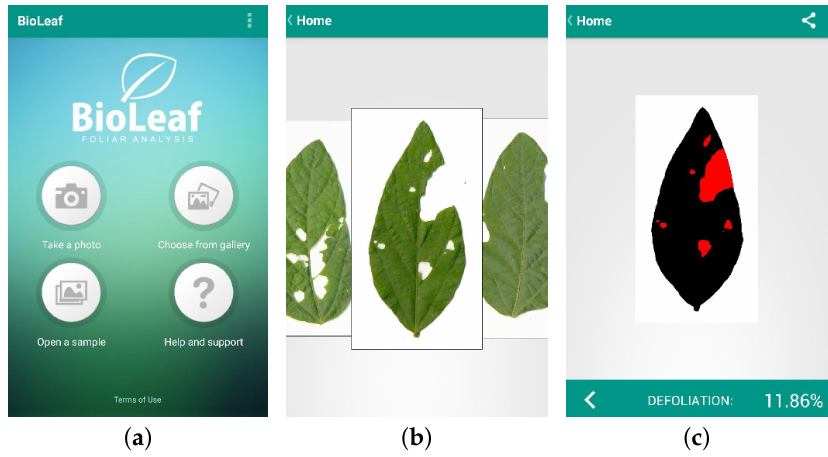
Bioleaf: ( a ) Main menu; ( b ) Captured leaf image; ( c ) Image segmentation and processing